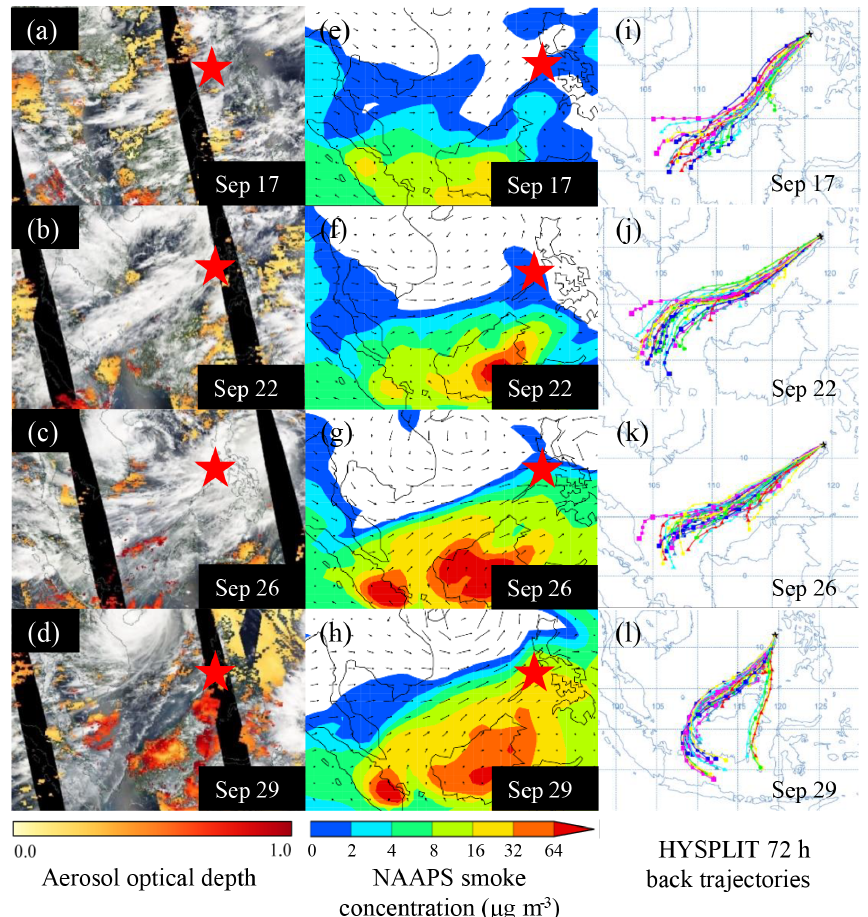
Figure 2. Satellite images of the SCS region taken from (a–d) NASA Worldview with an overlaid AOD; (e–h) NAAPS smoke concentration plots (µgm − 3 ; 850hPa); and (i–l) HYSPLIT ensemble back trajectories during the cruise for 17, 22, 26, and 29 September (isobaric; 300ma.g.l.; 72h; ending at 00:00UTC, i.e., 08:00LT). The red star indicates location of the Vasco